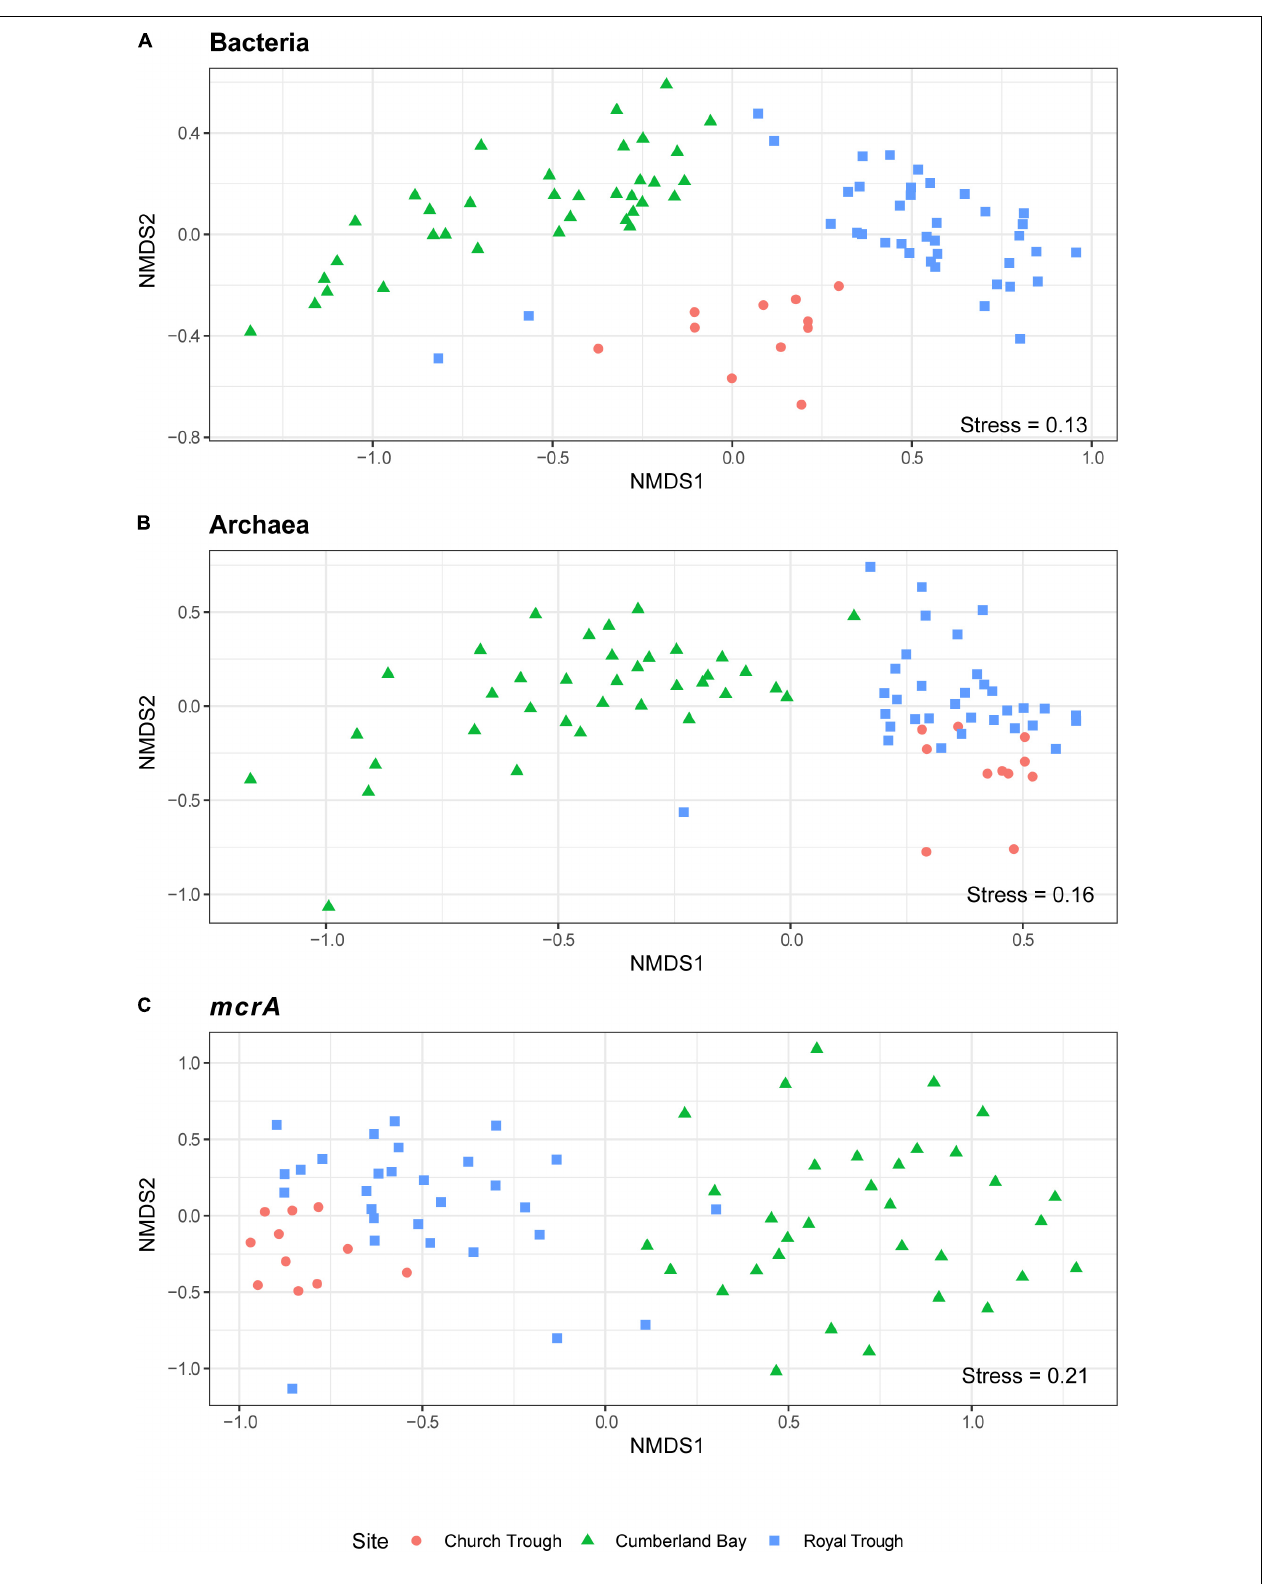
FIGURE 6 | Site-specific β -diversity patterns of Cumberland Bay, Church Trough and Royal Trough. NMDS ordination of abundant OTUs ( > 1000 sequences) based on sequencing of the (A) bacterial 16S rRNA gene, (B) archaeal 16S rRNA gene, and (C) mcrA gene.